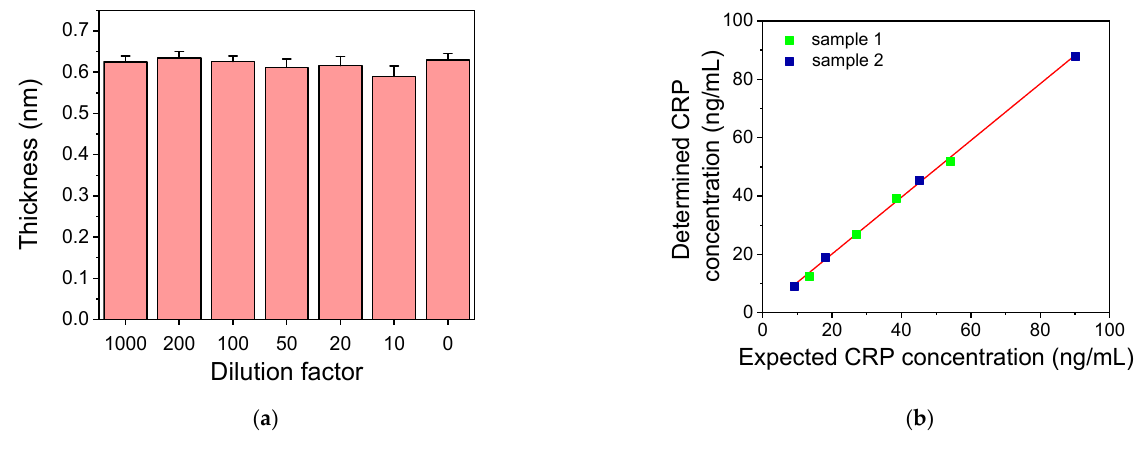
Figure 5. ( a ) Sensor responses obtained upon running a 50 ng/mL CRP solution prepared in assay buffer or in CRP-free human plasma diluted 10–200 folds with assay buffer. Each point is the mean value of three measurements ± SD. ( b ) Plotting of CRP concentration values determined in two plasma samples of known concentration after sequential dilution with assay buffer versus the expected CRP values in the diluted samples.